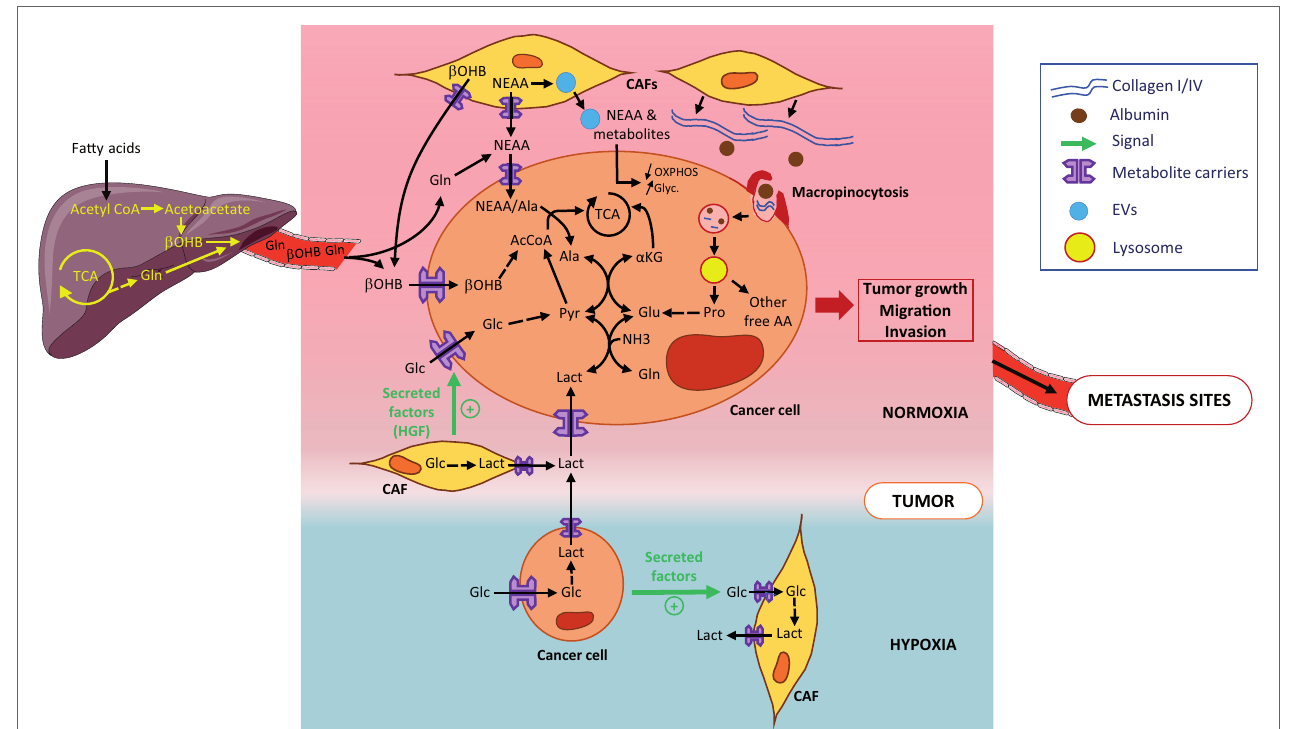
FiGURe 1 | Metabolic symbiosis and recycling in primary tumors. Tumor cells obtain metabolites and AA either from the circulation or from the local microenvironment. Metabolites, such as β -OHB or Gln are released into the circulation by the liver and reach the normoxic tumor (pink zone). At the primary tumor site, AA and other metabolites are locally released by cancer-associated fibroblats (CAFs) (yellow cells). Tumor cells (light brown cells) directly take up AA and metabolites through metabolite carriers or indirectly by (1) uptake of metabolites-loaded EVs from CAFs and (2) macropinocytosis of extracellular matrix such as collagen or scavenging of macromolecules such as albumin. Macropinosomes are internalized and fused with lysosomes where collagen and albumin are degraded into free proline and free AA, all released in the cytosol. Lactate secreted by hypoxic tumor cells (localized in blue zone) is taken up by normoxic tumor cells through the metabolic symbiosis. The most part of AA and metabolites provided to tumor cells are used to contribute to the TCA. All are shown to contribute to tumor growth and metastatic potential of tumor cells. Abbreviations: AAs, amino acids; NEAAs, non-essential amino acids; Ala, alanine; Glc, glucose; Pyr, pyruvate; Lact, lactate; α KG, α -ketoglutarate; Glu, glutamate; Gln, glutamine; β -OHB, β -hydroxybutyrate; EVs, extracellular vesicles; TCA, tricarboxylic cycle; OXPHOS, oxidative phosphorylation; Glyc,